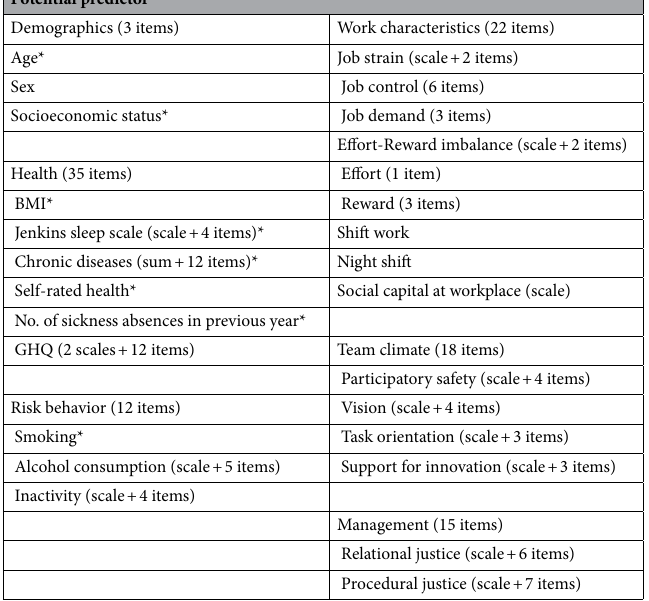
Table 1. Potential predictors. *Items included in the